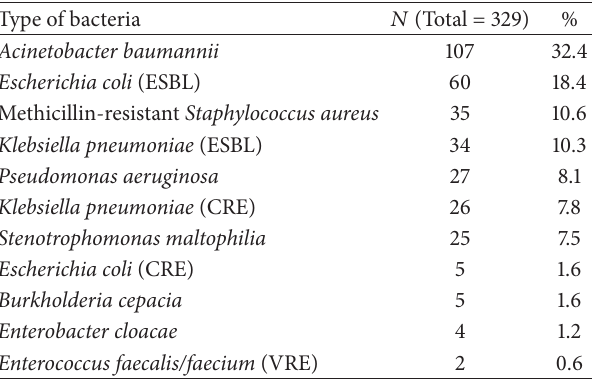
Table 3: Distribution of hospital-acquired multidrug resistant organisms (MDRO) by type of bacteria at a tertiary care hospital in Oman,